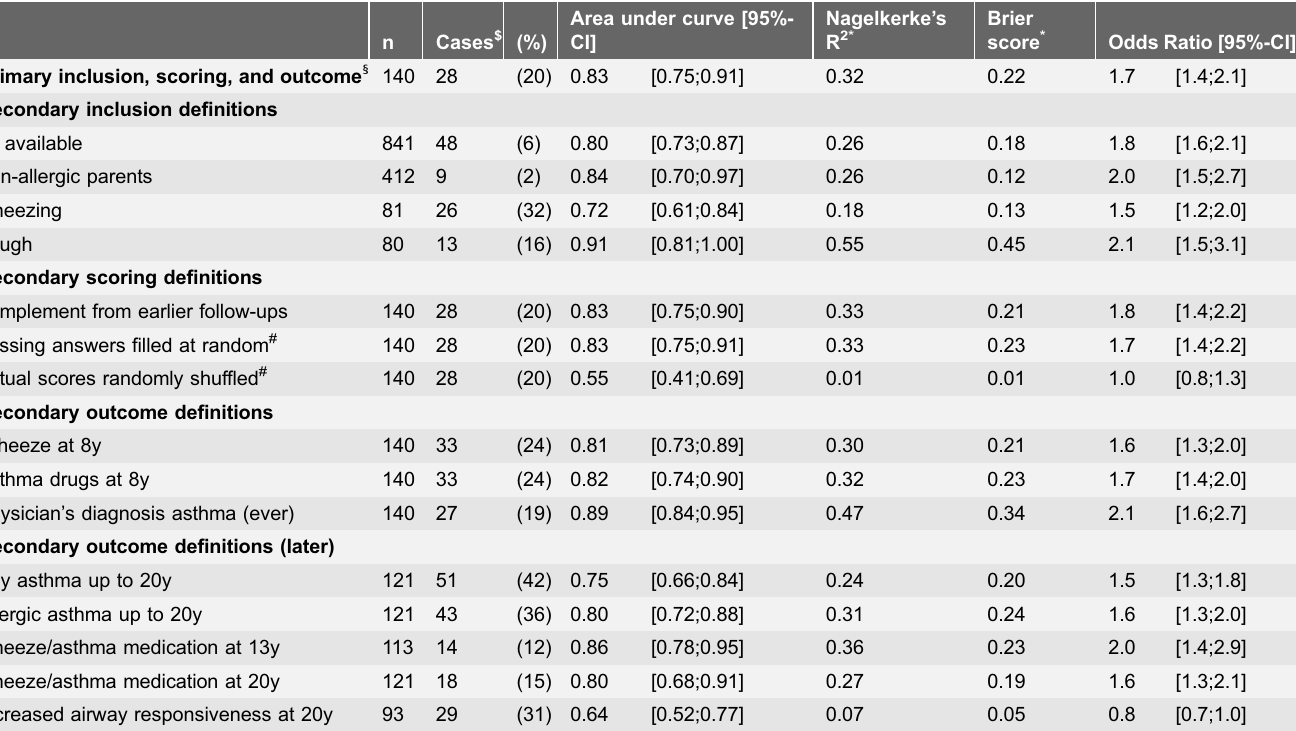
Table 5. Discrimination and Performance of the asthma prediction score in the MAS-90 birth cohort used for external validation. Area under curve [95%- n Cases $ (%)